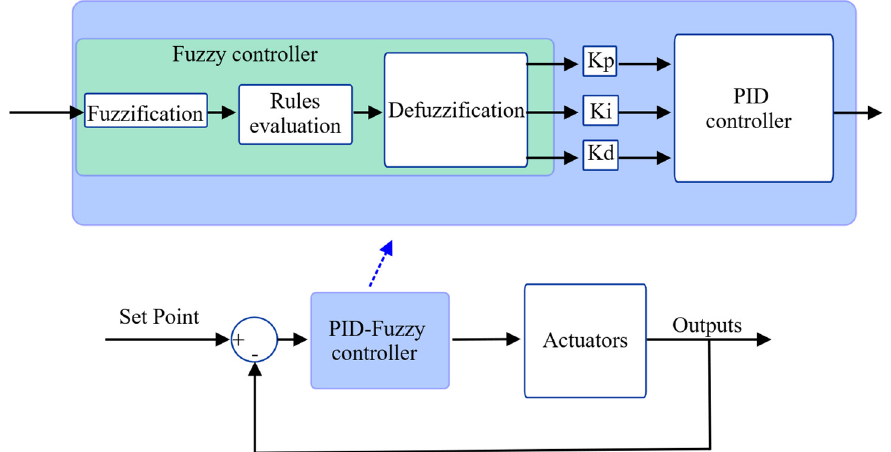
Figure 3. General scheme of a PID-fuzzy